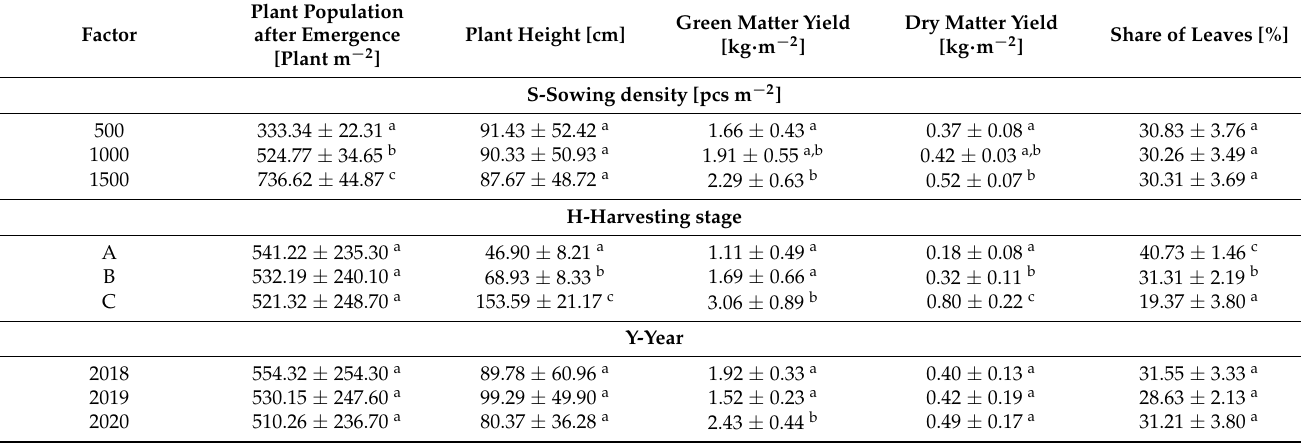
Table 3. Plant measurements and yield of annual white sweet